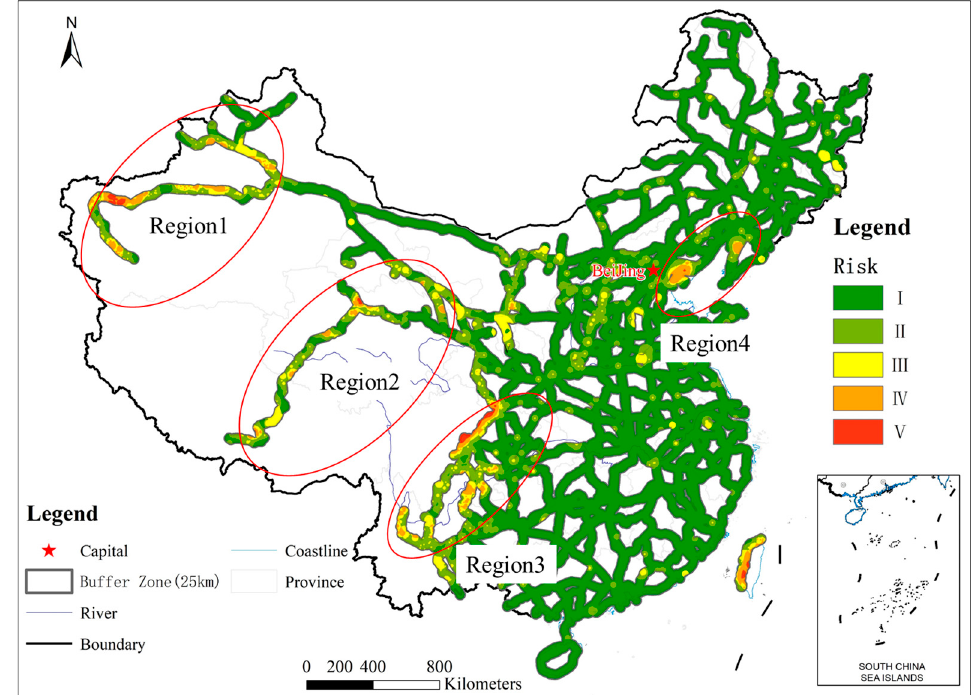
Figure 9. Hazard assessment of earthquake disasters.